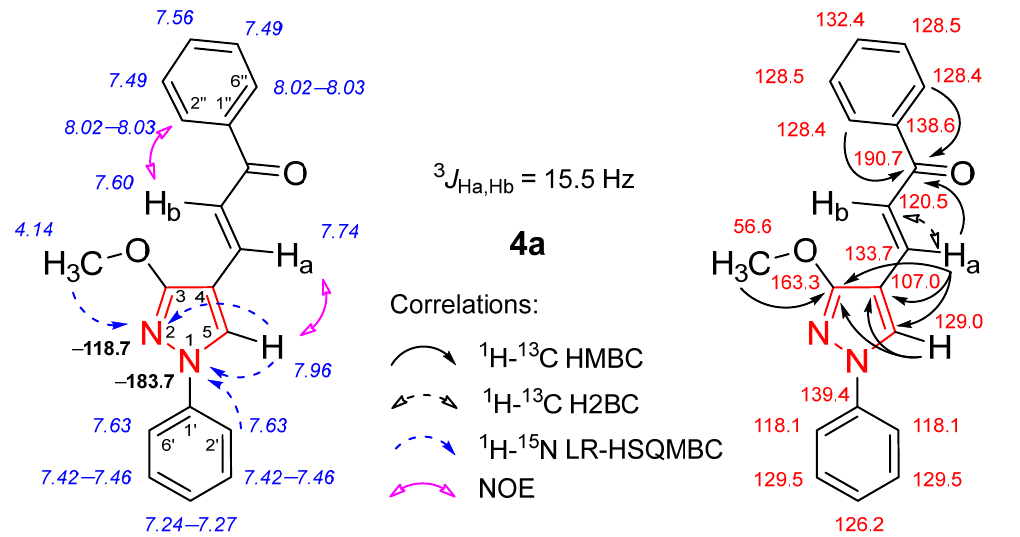
Figure 2. Relevant 1 H- 13 C HMBC, 1 H- 13 C H2BC, 1 H- 15 N LR-HSQMBC and 1 H- 1 H NOESY correlations and 1 H NMR (italics), 13 C NMR and 15 N NMR (bold) chemical shifts of compound 4a . The obtained ( E )-3-[3-(benzyloxy)-1-phenyl-1 H -pyrazol-4-yl]-1-phenylprop-2-en-1-ones 4g – i were further treated with trifluoroacetic acid for debenzylation. ( E )-3-(3-Hydroxy-1-phenyl-1 H -pyrazol-4-yl)-1-phenylprop-2-en-1-ones 5a – c were obtained in fair to good yields (63–83%), as outlined in Scheme 2. As expected, the cleavage of the OCH 3 group (compound 5b ) under the given conditions was not observed.